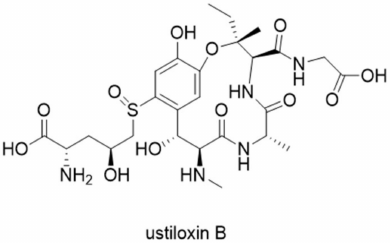
Figure 7. Structure of ustiloxin